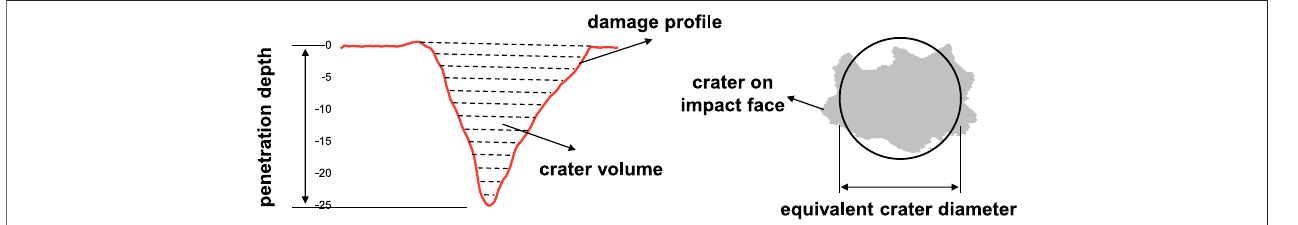
FIGURE 2 | Illustration on the measurement of DOP, CD, and CV.